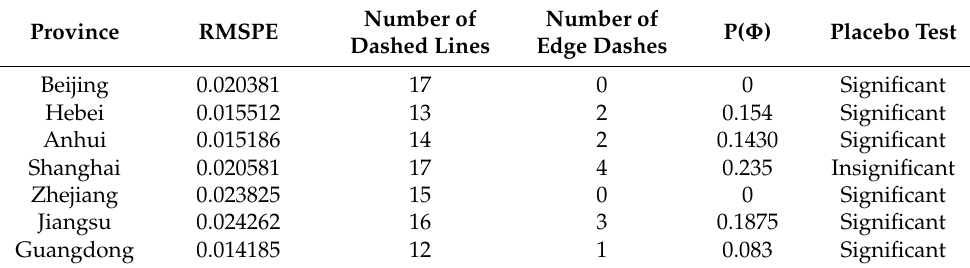
Figure 4. Robustness Tests for Changing Policy Point-in-Time. Table 7. Placebo test